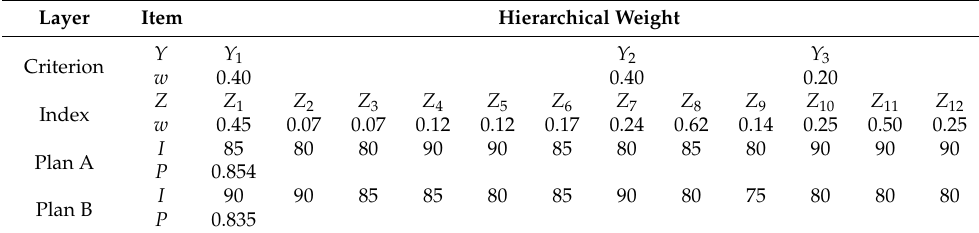
Table 14. Performance coefficients determination of replacement